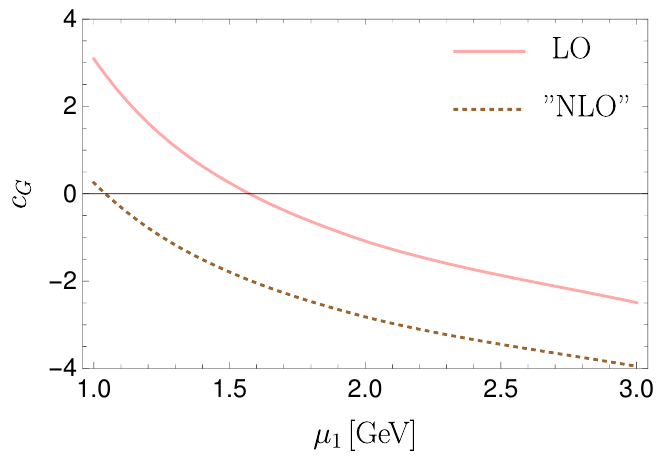
Figure 3 . Scale dependence of the coefficient of the chromomagnetic